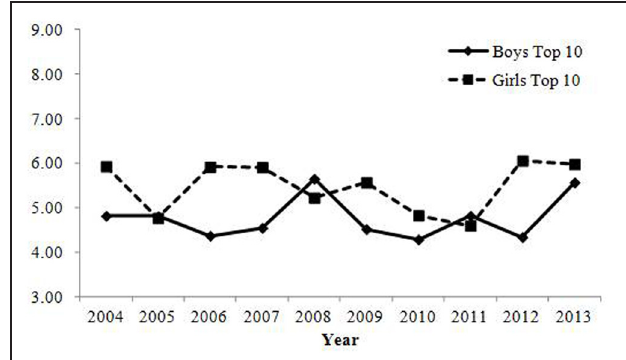
FIGURE 5 | Percentage of babies receiving names with one of the top 10 most common pronunciations in Study 2. The rate of babies with common pronunciation in boys has decreased and changes were sufficiently large in magnitude. In contrast, the correlation between year and the rate of babies with common pronunciations in girls were below the criterion. However, it should be noted that there were greater fluctuations due to the inclusion of many duplicated